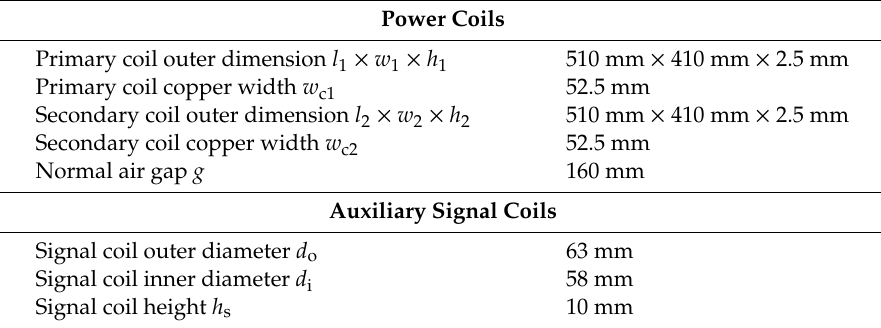
Table 1. Coil dimensions.